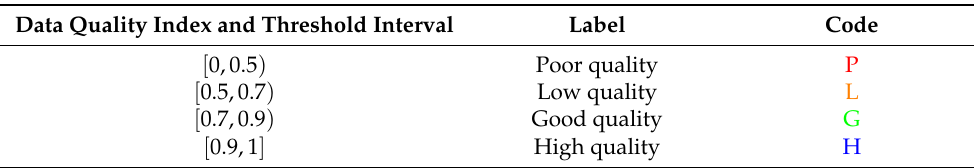
Table 5. Quality indexes and thresholds